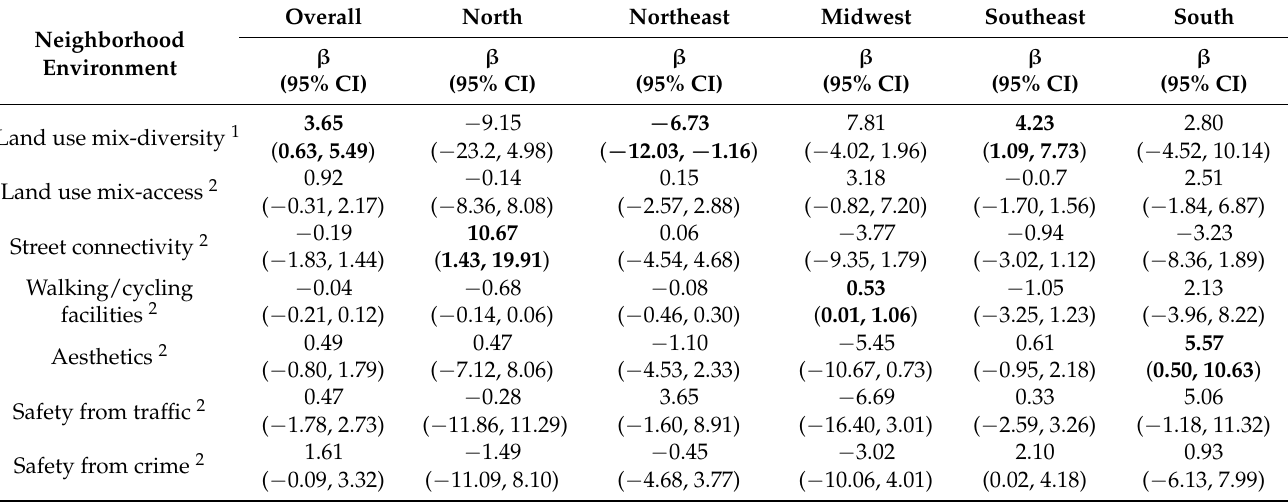
Table 3. Association ( β [95% CI]) between perceived neighborhood-built environment and transport physical activity